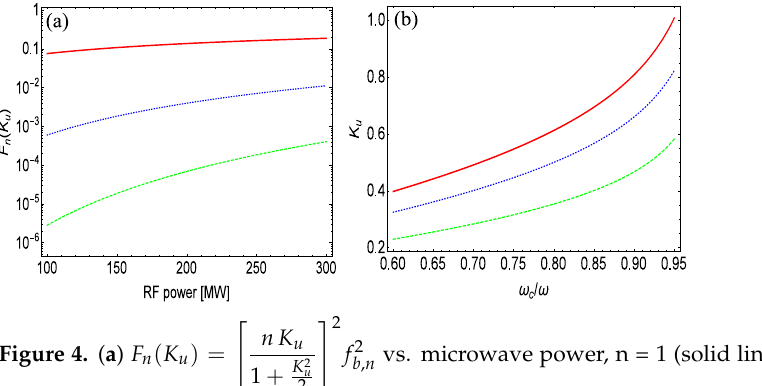
Figure 4. ( a ) F n ( K u ) = n = 5 (dashed line); ( b ) strength parameter K u vs. 300 MW (solid), 200 MW (dotted), 100 MW (dashed).